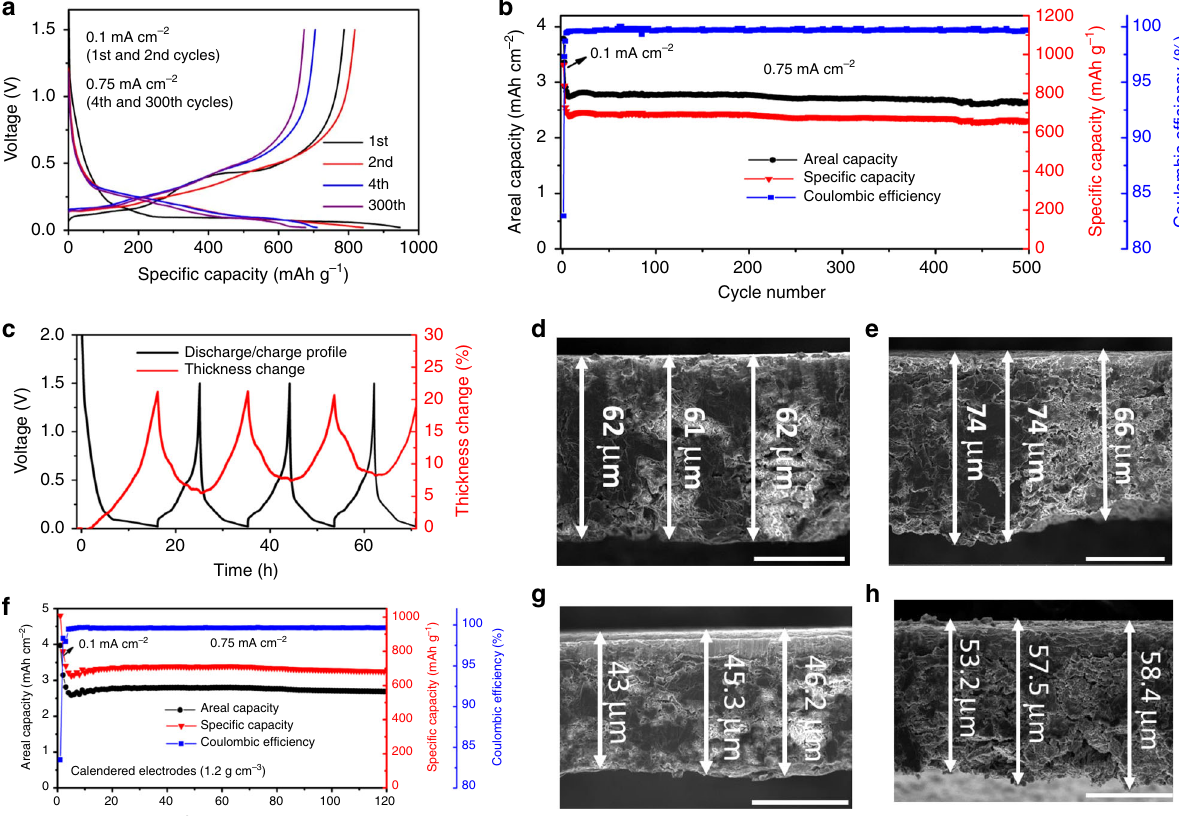
Fig. 4 Electrochemical characterization of the CNT@Si@C-graphite anodes (30 wt% : 58 wt%) in half-cells. a Typical voltage curves of a CNT@Si@C and graphite composite anode with ~3 mAh cm − 2 loading. The mass loading of the electrodes in Fig. 4 is 4.0 mg cm − 2 . b Cycling behavior of the same anode in a . c In-situ measurement of electrode swelling during discharge – charge at 0.2 mA cm − 2 . d SEM image of a pristine electrode (scale bar = 30 µ m). e SEM image of a fully lithiated electrode after 1 cycle (scale bar = 30 µ m). f Cycling stability of an electrode calendered to 1.2 g cm − 3 . g SEM image of an electrode after calendering to 1.2 g cm − 3 while before cycling (scale bar = 30 µ m). h SEM image of the calendered electrode at full lithiation state after 120 cycles (scale bar = 30 µ